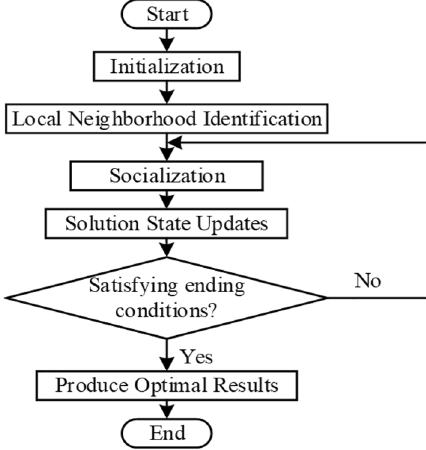
Fig. 1 A proposed framework for multi-agent-based metaheuristic